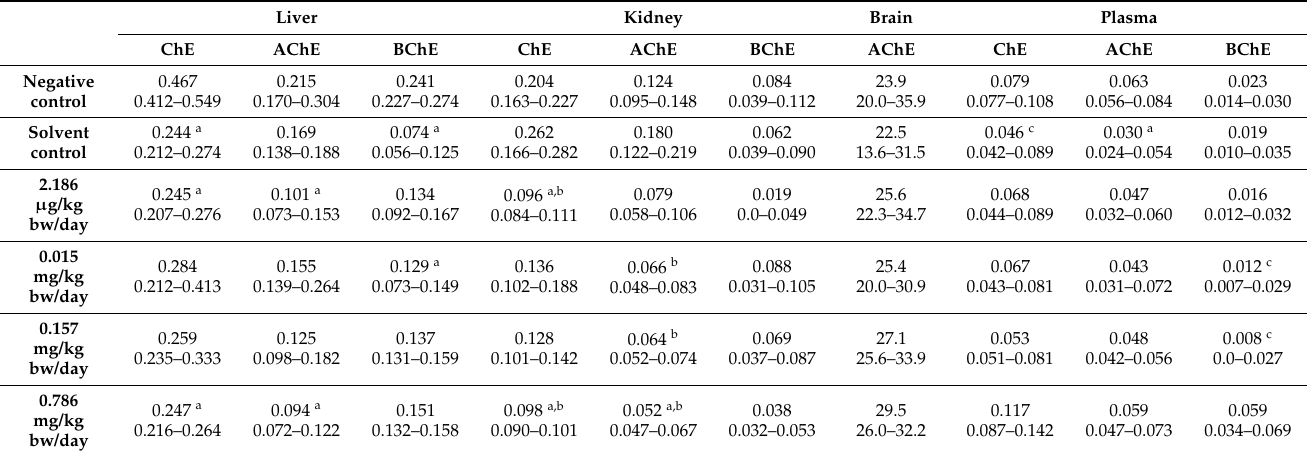
Table 2. Changes in cholinesterase activities (IU/g protein) in liver, kidney, brain, and plasma of adult male Wistar rats orally exposed to different doses (mg/kg bw/day) of α -cypermethrin for 28 consecutive